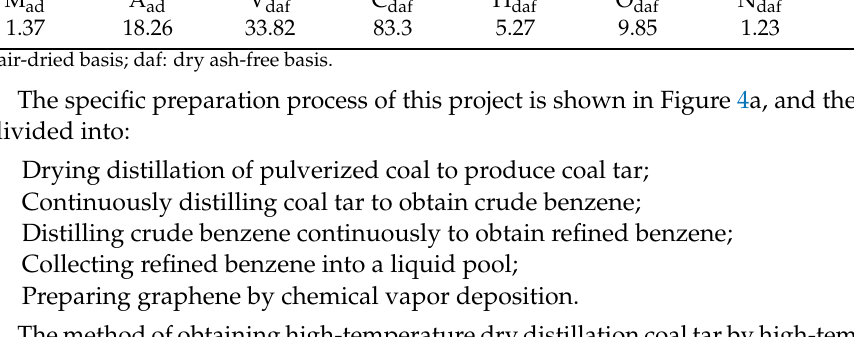
Table 1. Basic properties of HNGC samples after demineralization. Proximate Analysis